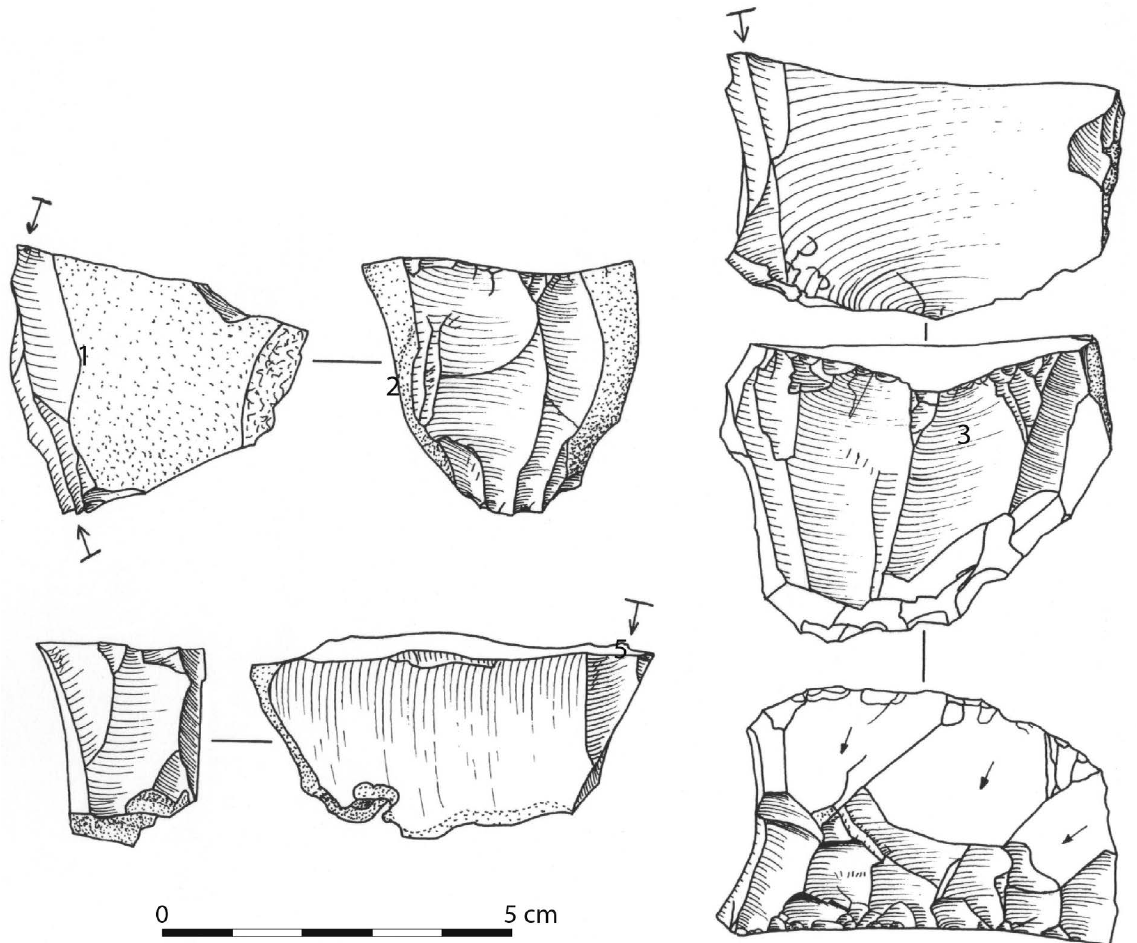
Figure 12. Exemple de nucléus Cerny du site de Bouafles « La plante à Tabac » (Eure). Dessin de D. Prost. Figure 12. Cerny core from Bouafles « La plante à Tabac » (Eure). Drawing by D. Prost. Ces quelques exemples bibliographiques, montrent donc de nettes